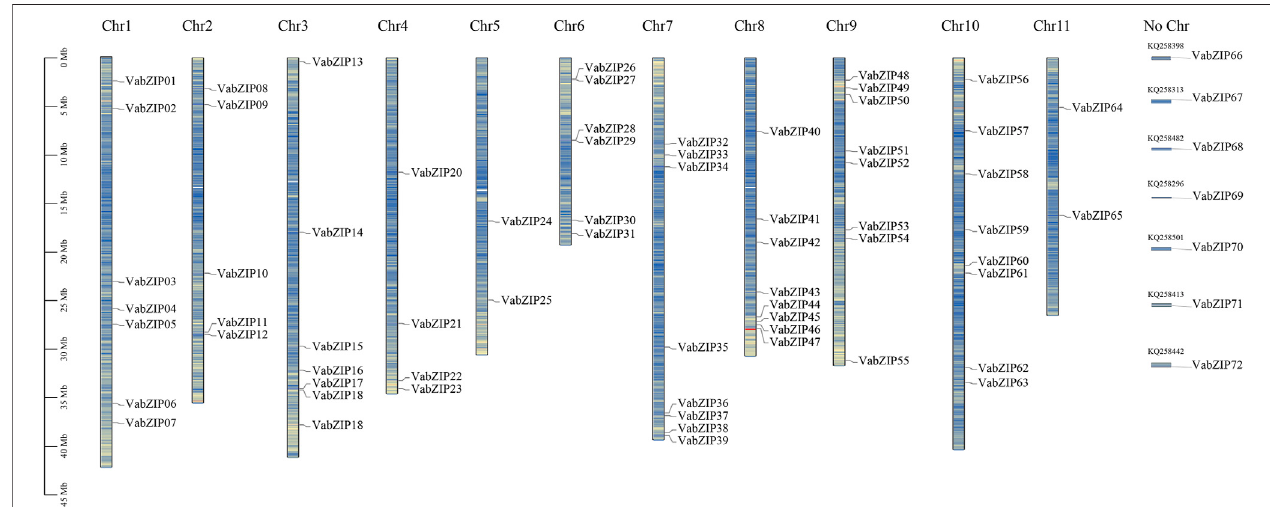
FIGURE1| Locations ofVabZIP members. The11pillarscorrespondtothe11chromosomes,whereas NoChr depictmemberslackingachromosome.Theblue lines indicate gene density on